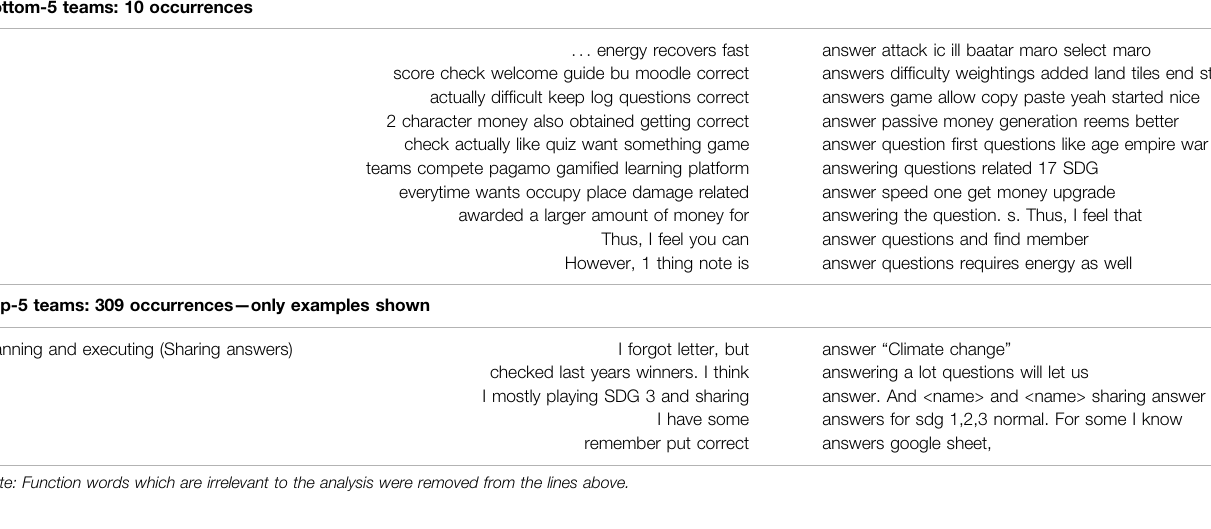
TABLE 4 | Lines of chat histories with the keyword “ land(s) ” appeared in the 2020 bottom- and top-5 teams. Bottom-5 teams: 13 occurrences Planning and executing (Strategy)